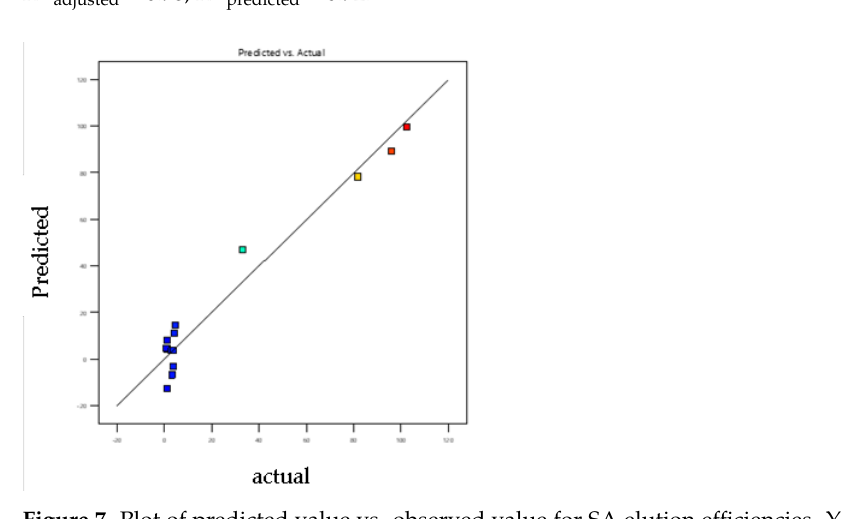
Figure 7. Plot of predicted value vs. observed value for SA elution efficiencies. Y Predicted p < 0.04 R2 adjusted = 0.92, R 2 predicted = 0.82 .